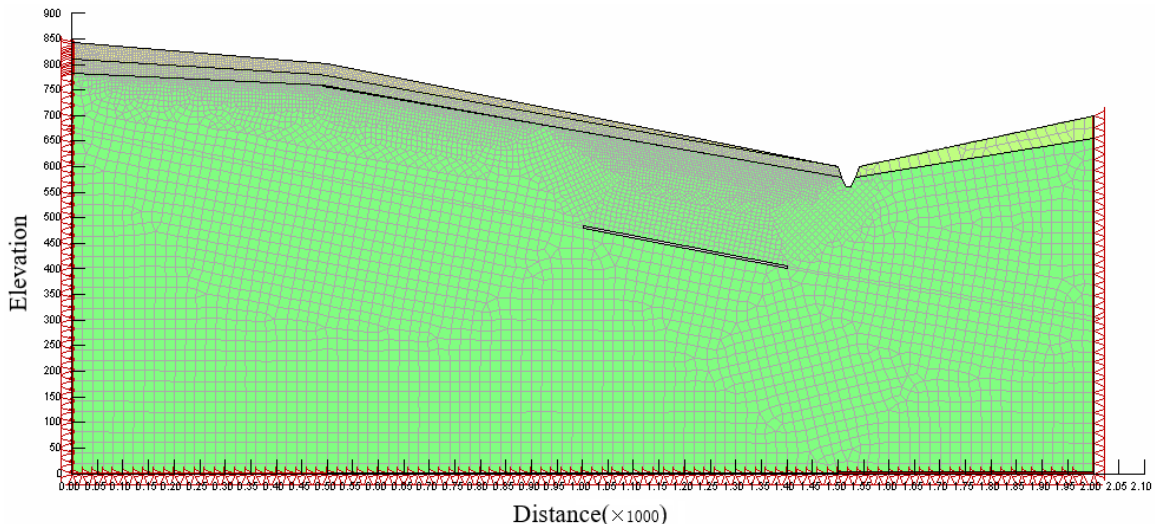
Figure 4. Finite element calculation model of slope before landslide and after mining in the Tanshan Coal Mine.